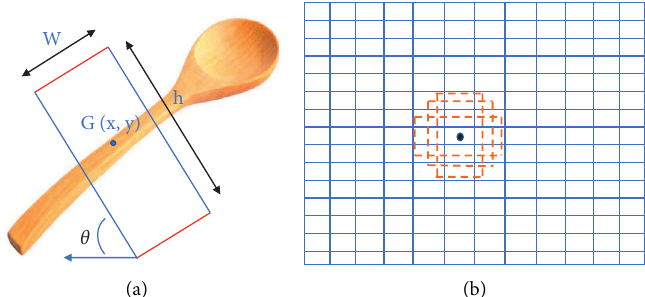
Figure 1: (a) Grasp configuration for parallel robotic gripper. Each grasp configuration contains the position information, orientation information, and grasp quality score. (b) Each anchor is corresponded to 9 possible grasp boxes with 3 scales and 3 aspect ratios (here only shows 3 of the possible grasp boxes of a same